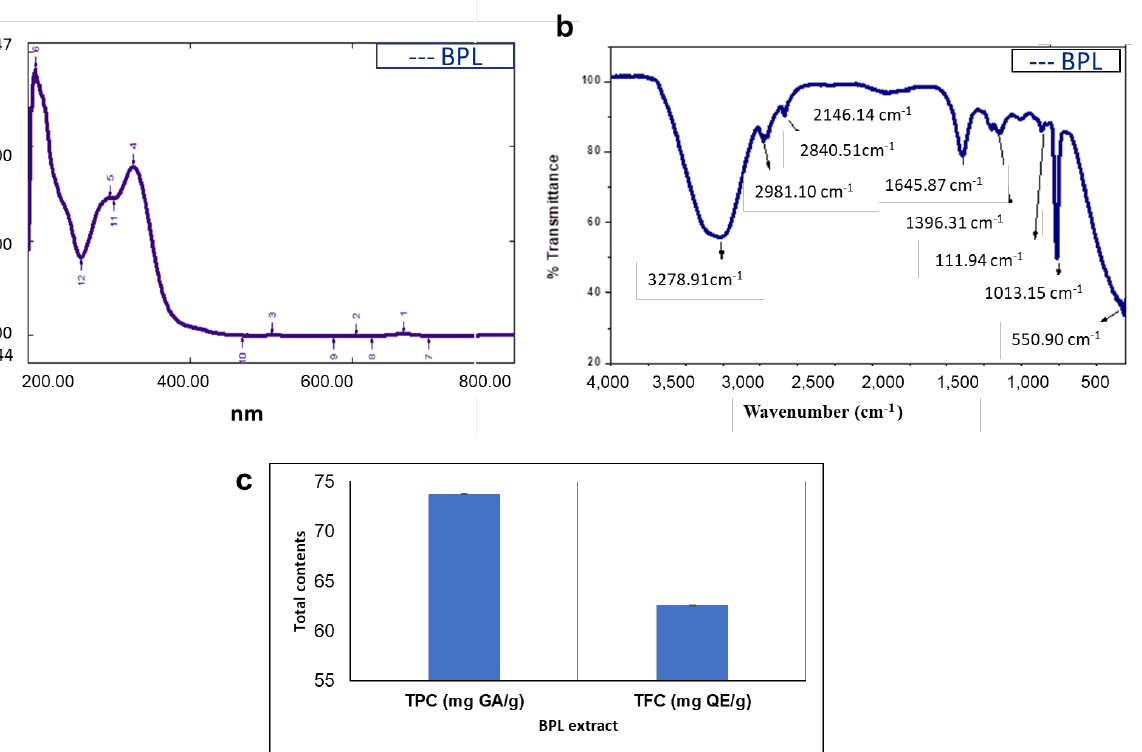
Figure 1. Spectroscopic and phytochemical profile of BPL extract ( a ) UV-Visible spectroscopy ( b ) FTIR analysis ( c ) TPC and TFC.